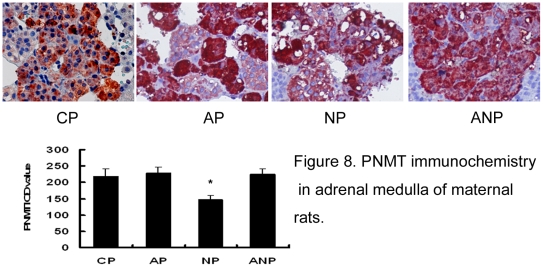
PNMT immunochemistry in adrenal medulla of maternal rats.The expression of PNMT decreased in NP rats significantly compared with
CP rats. IOD values are expressed as mean
±SEM(n = 8); * P<0.05 vs CP. (The
magnification of the image is 400 ×).